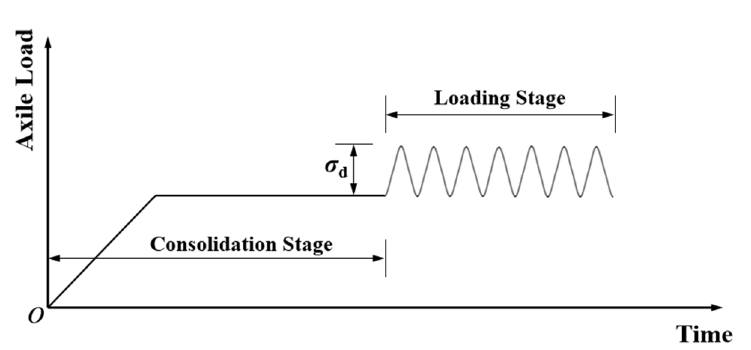
Figure 6. Dynamic load motion used in the